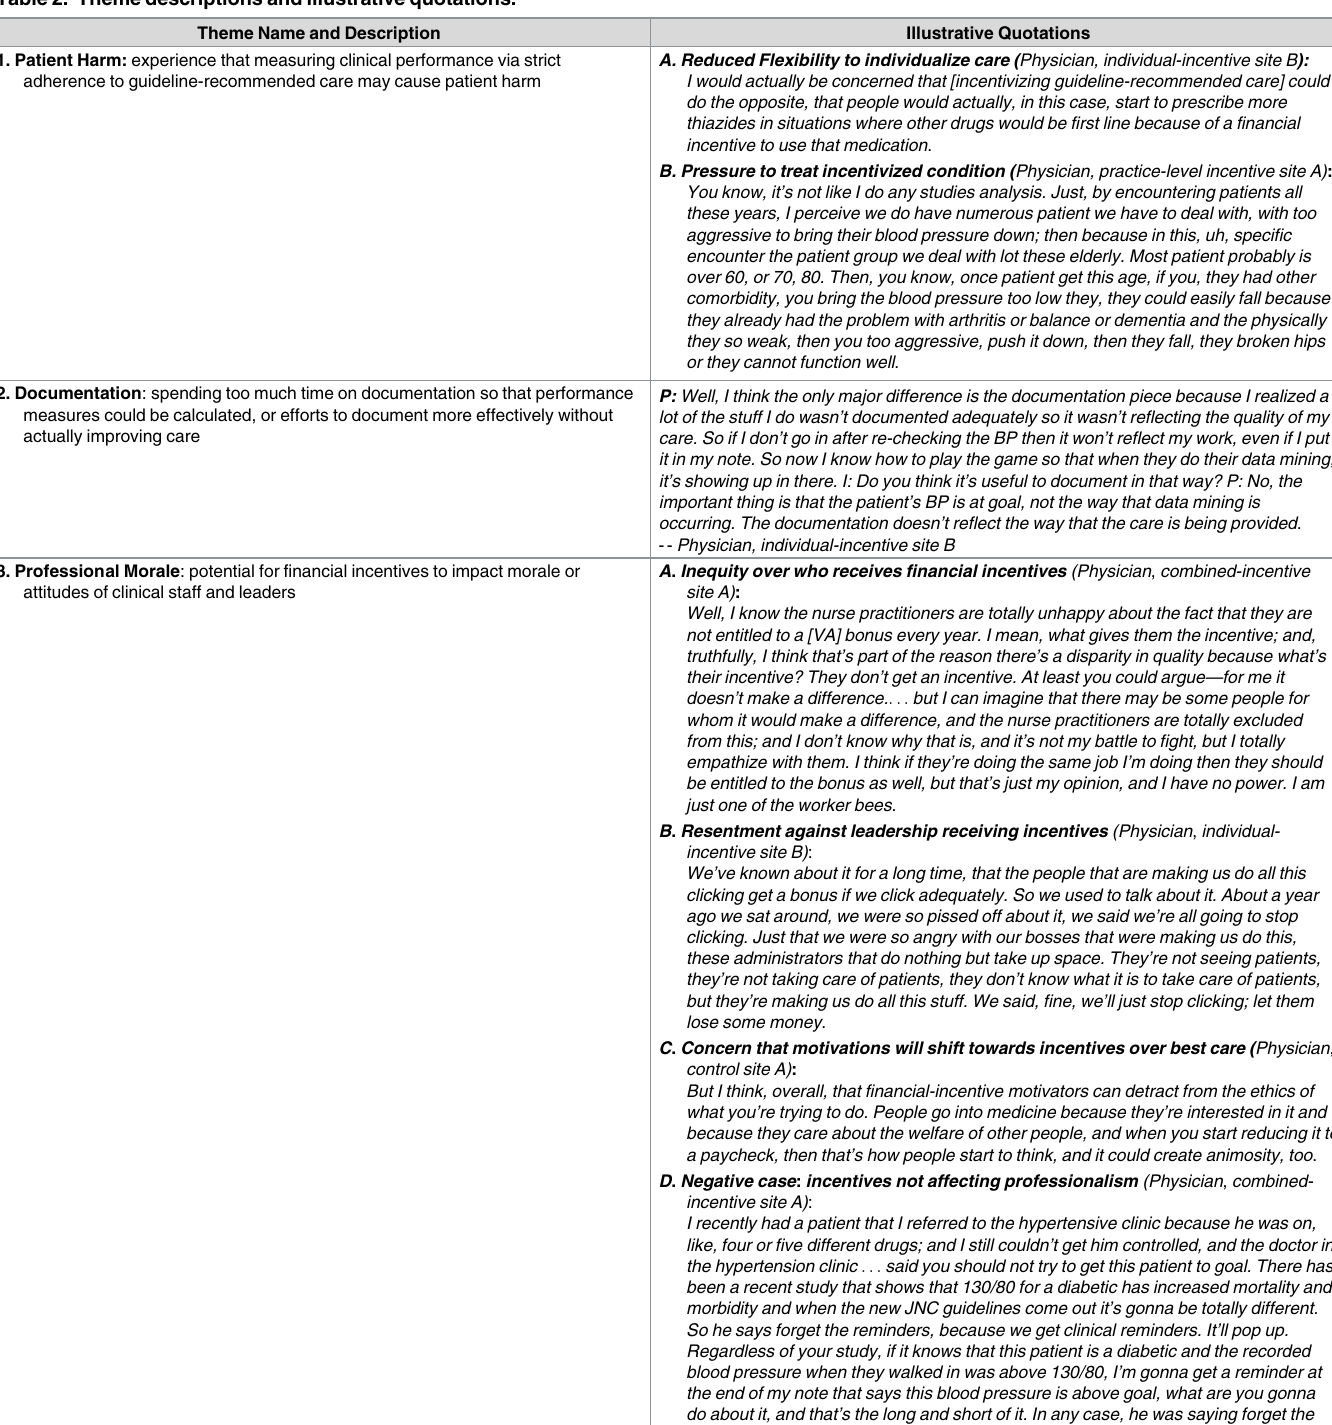
Table 2. Theme descriptions and illustrative